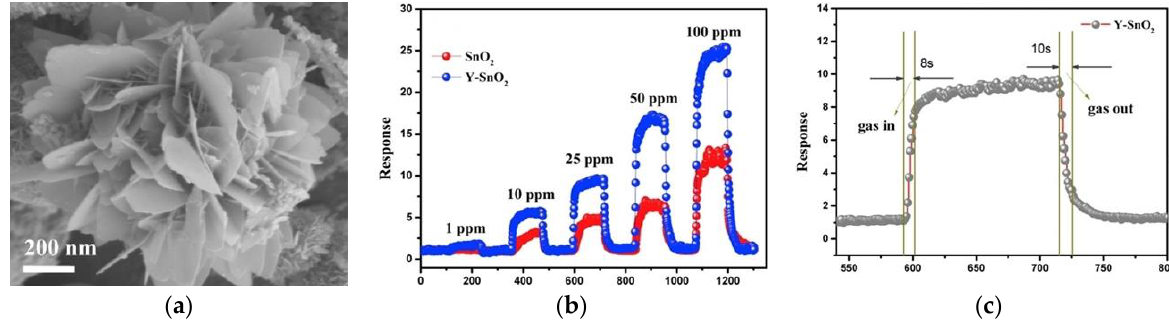
Figure 7. ( a ) SEM images of Y-doped SnO 2 ; ( b ) the response/recovery curves to 1–100 ppm HCHO; ( c ) the dynamic sensing transient to 25 ppm HCHO of SnO 2 and Y-doped SnO 2 [57].